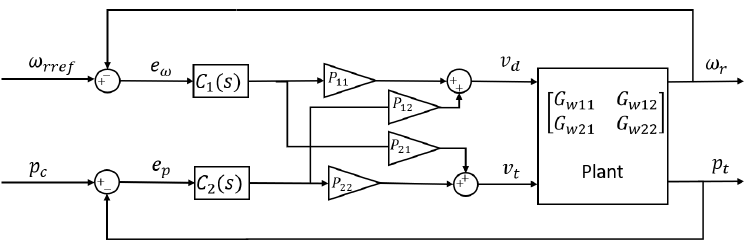
Figure 9. Schematic of the test phase control